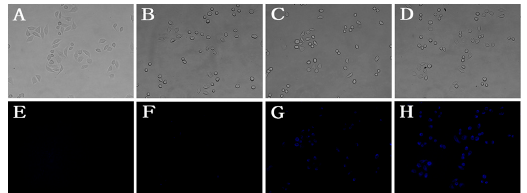
Figure 7. Images of living HeLa cells: HeLa cells incubated with different concentration of probe 1 (( A , E ) 0 µ M; ( B , F ) 2.5 µ M; ( C , G ) 5 µ M; ( D , H ) 10 µ M) for 1 h and then all cells were incubated with 80 µ M CN − for 15 min. ( A – D ) is Bright field; ( E – H ) is under fluorescence ( λ ex = 385